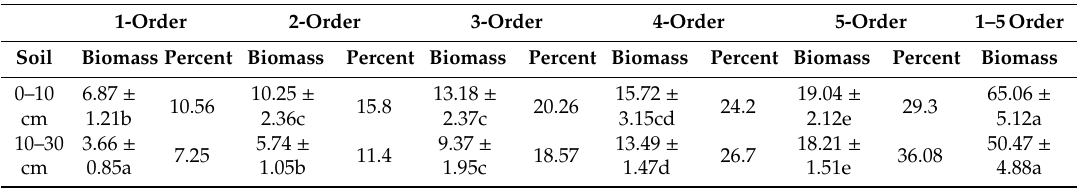
Table 2. Fine root biomass in each soil depth of crop trees.